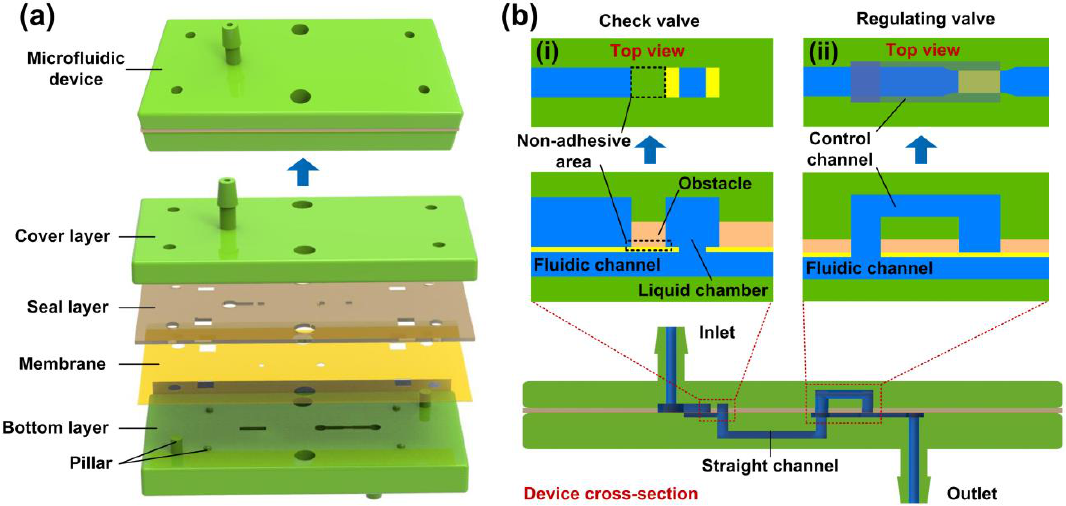
Figure 2. Schematic structure of the microfluidic flow regulatory device. ( a ) Explosive view of the device; ( b ) Microchannel structures of the device. Inset images (i) and (ii) illustrating the top views and the cross-section views of the flow check valve and the flow regulating valve. The black dashed frame indicates the non-adhesive area in the flow check valve.